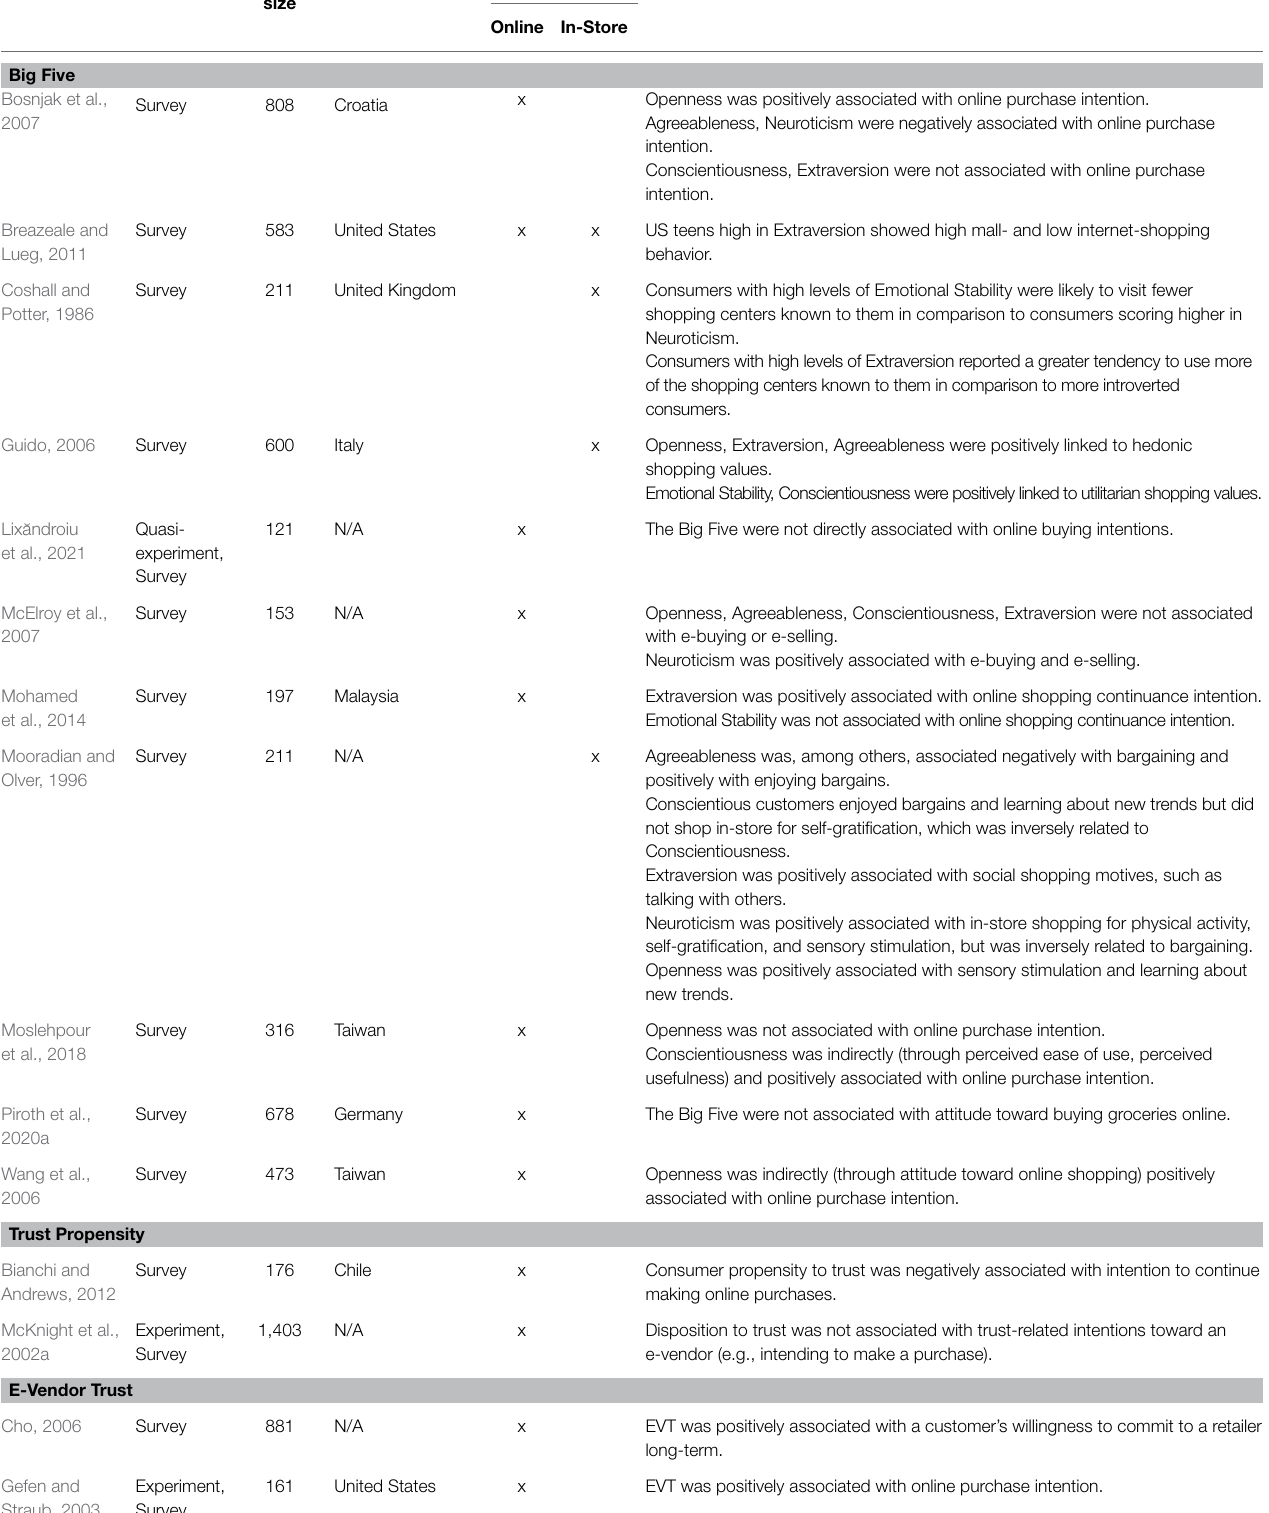
TABLE 1 | Summary of related work examining the relations of the Big Five, trust, and NFT with online and in-store purchase